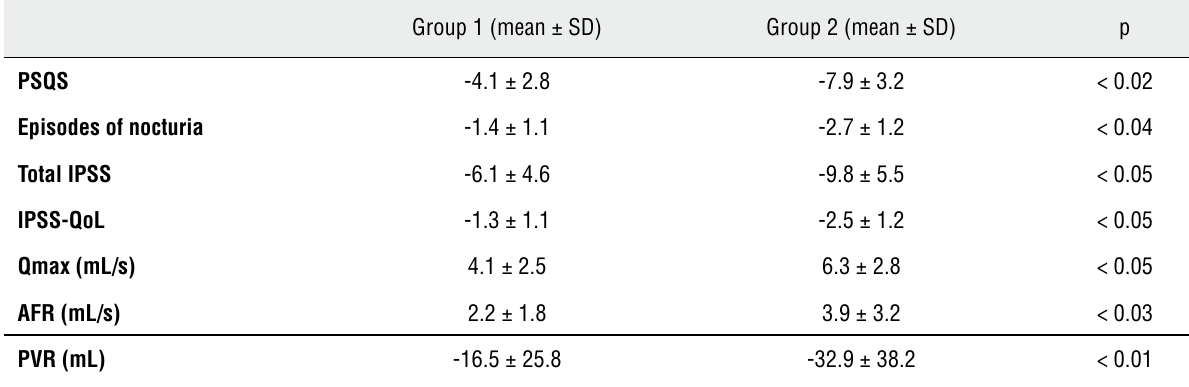
Table 2 - Mean changes over baseline of both groups after the